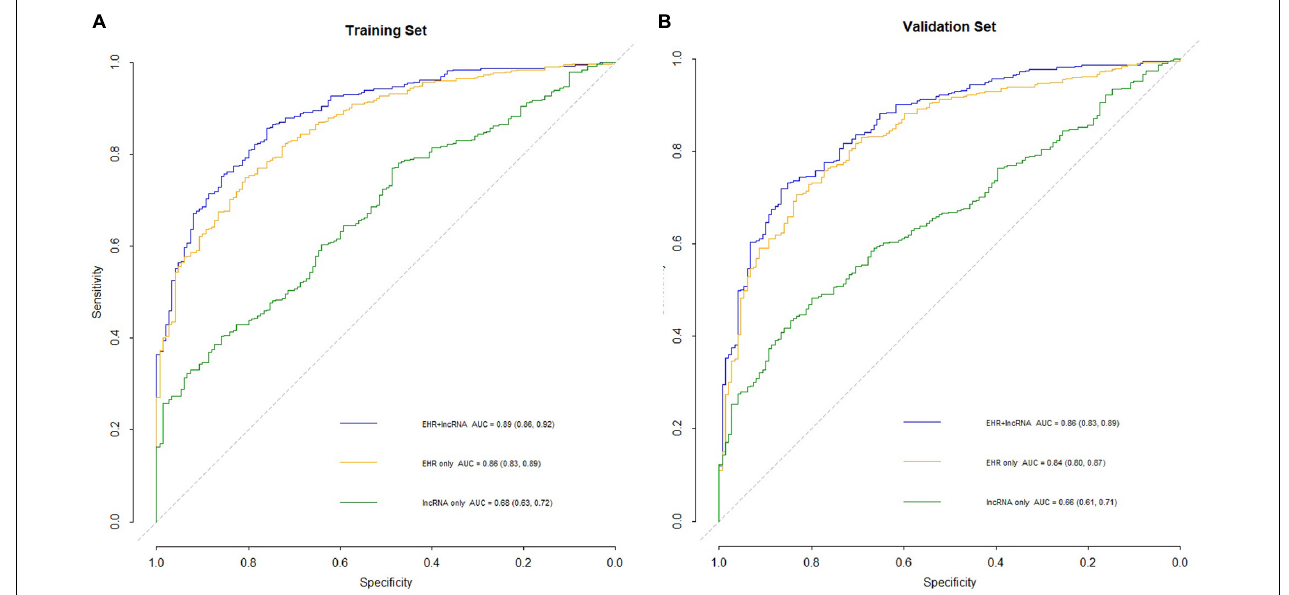
FIGURE 4 | ROC curves of the three models in selection cohort.